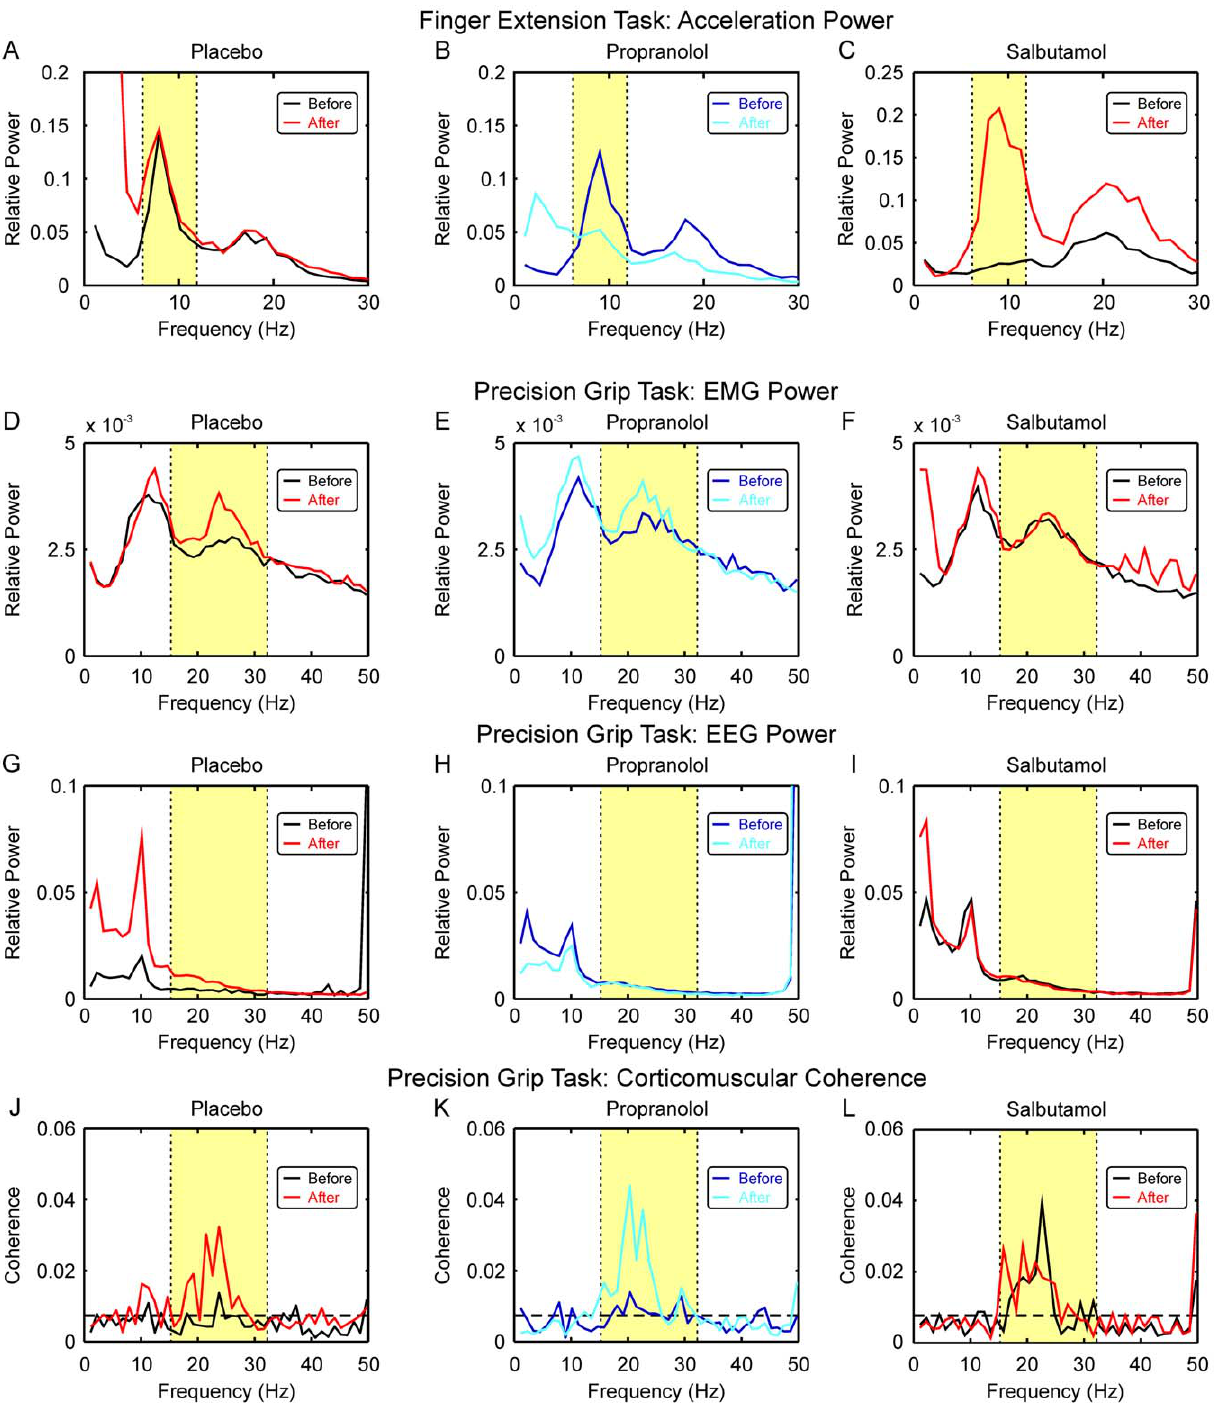
Figure 2. Single Subject Data. Each column of this figure refers to the effects of a different substance: placebo (A,D,G,J), propranolol (B,E,H,K) and salbutamol (C,F,I,L). A–C, effect on postural tremor during an index finger extension task. Traces show the power spectrum of the finger acceleration, before and after substance ingestion. Yellow shaded region corresponds to the band of physiological tremor (6.2–11.9 Hz). D–F, effect on EMG power. G–I, effect on EEG power. J–L, effect on corticomuscular coherence. In (D–L), all measurements were made during the second hold phase of a hold-ramp-hold auxotonic precision grip task (see Methods). Yellow shaded region marks the 15.3–32.2 Hz band of beta oscillations. EMG power spectra (D–F) and corticomuscular coherence (J–L) have been averaged over all five muscles recorded. In (J–L), horizontal dashed lines indicate the significance level for the averaged coherence.